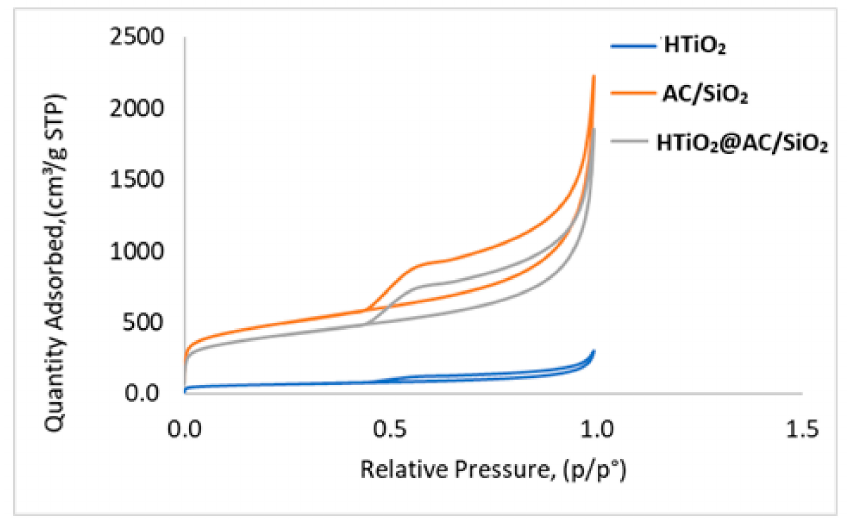
Figure 4. Adsorption–desorption isotherm.